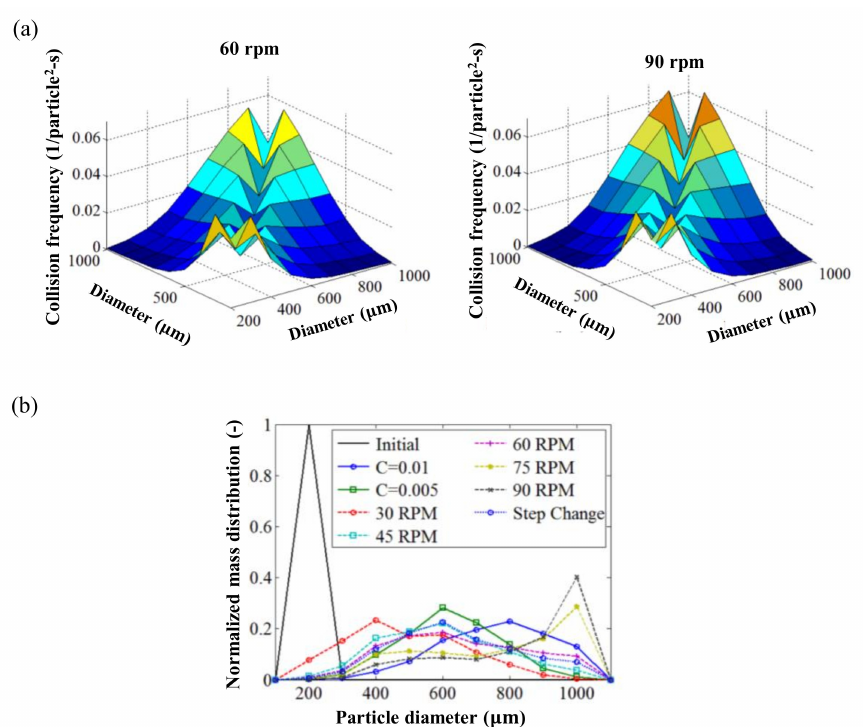
Figure 9. ( a ) Simulation result of collision frequency predictions at 60 and 90 rpm impeller speeds; ( b ) particle size distribution after 180 s depending on the constant collision frequencies (0.01 and 0.005) and impeller speeds (30–90 rpm) compared with the initial particle size distribution [84]. The figures were slightly modified, with permission from